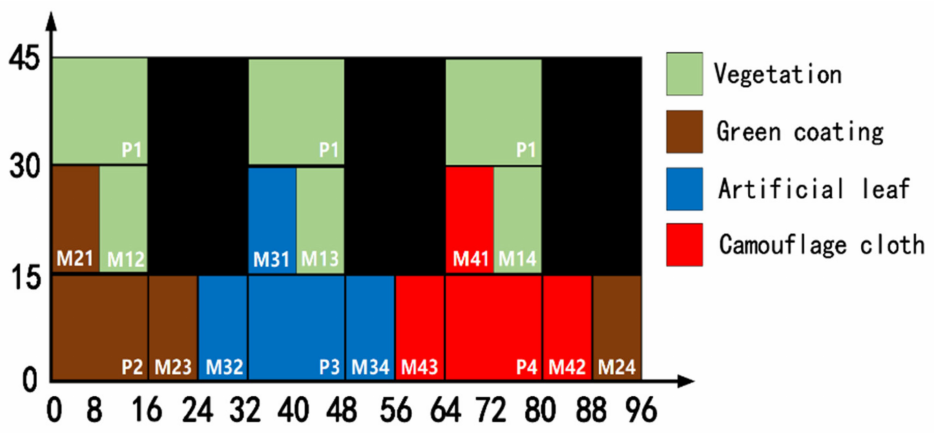
Figure 8. Simulation data label diagram (Ground Truth). Table 1. The meaning of the symbols in the space